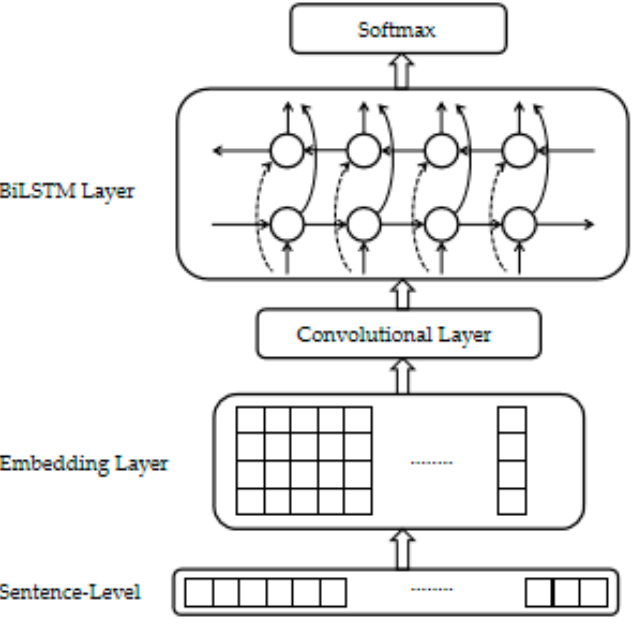
Figure 2. The C-BiLSTM model.